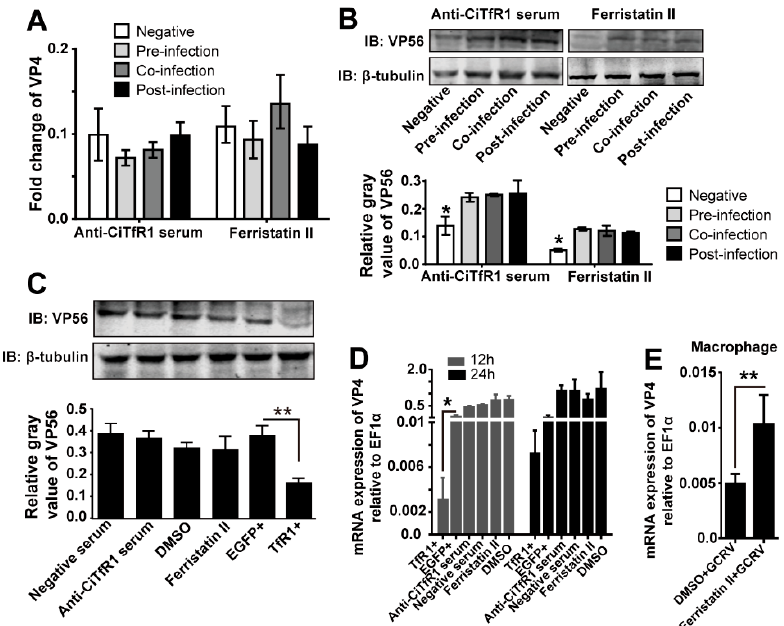
Figure 5. CiTfR1 is not a helper for GCRV infection. ( A , B ) The relative mRNA expression levels of VP4 ( A ) and the protein levels of VP56 (B) in PBS, anti-CiTfR1 serum, or Ferristatin II treated and GCRV infected CIK cells. CIK cells cultured in six-well plates were treated with either PBS, 100 µ M Ferristatin II, or 1% anti-CiTfR1 serum at 2 h preinfection, coinfection, or 2 h postinfection with GCRV at MOI of 1. Cells were harvested at 12 h p.i. for RNA isolation or WB analysis. ( C , D ) The protein levels of VP56 in the indicated cells were examined at 12 h p.i. The relative gray value of each band in three independent experiments was analyzed ( C ). mRNA expression levels of VP4 in the indicated cells were examined at 12 and 24 h p.i. ( D ). ( E ) Isolated macrophages were seeded into 12-well plates (5 × 10 5 / well) and then infected with GCRV (MOI = 1) and treated with 1 % DMSO or 100 µ M Ferristatin II. mRNA expression levels of VP4 in the indicated cells were examined at 12 h p.i. Data are presented in relative expression units where EF1 α was used to normalize all samples. Data represent mean ± SD of three independent experiments. * p < 0.05, ** p < 0.01.